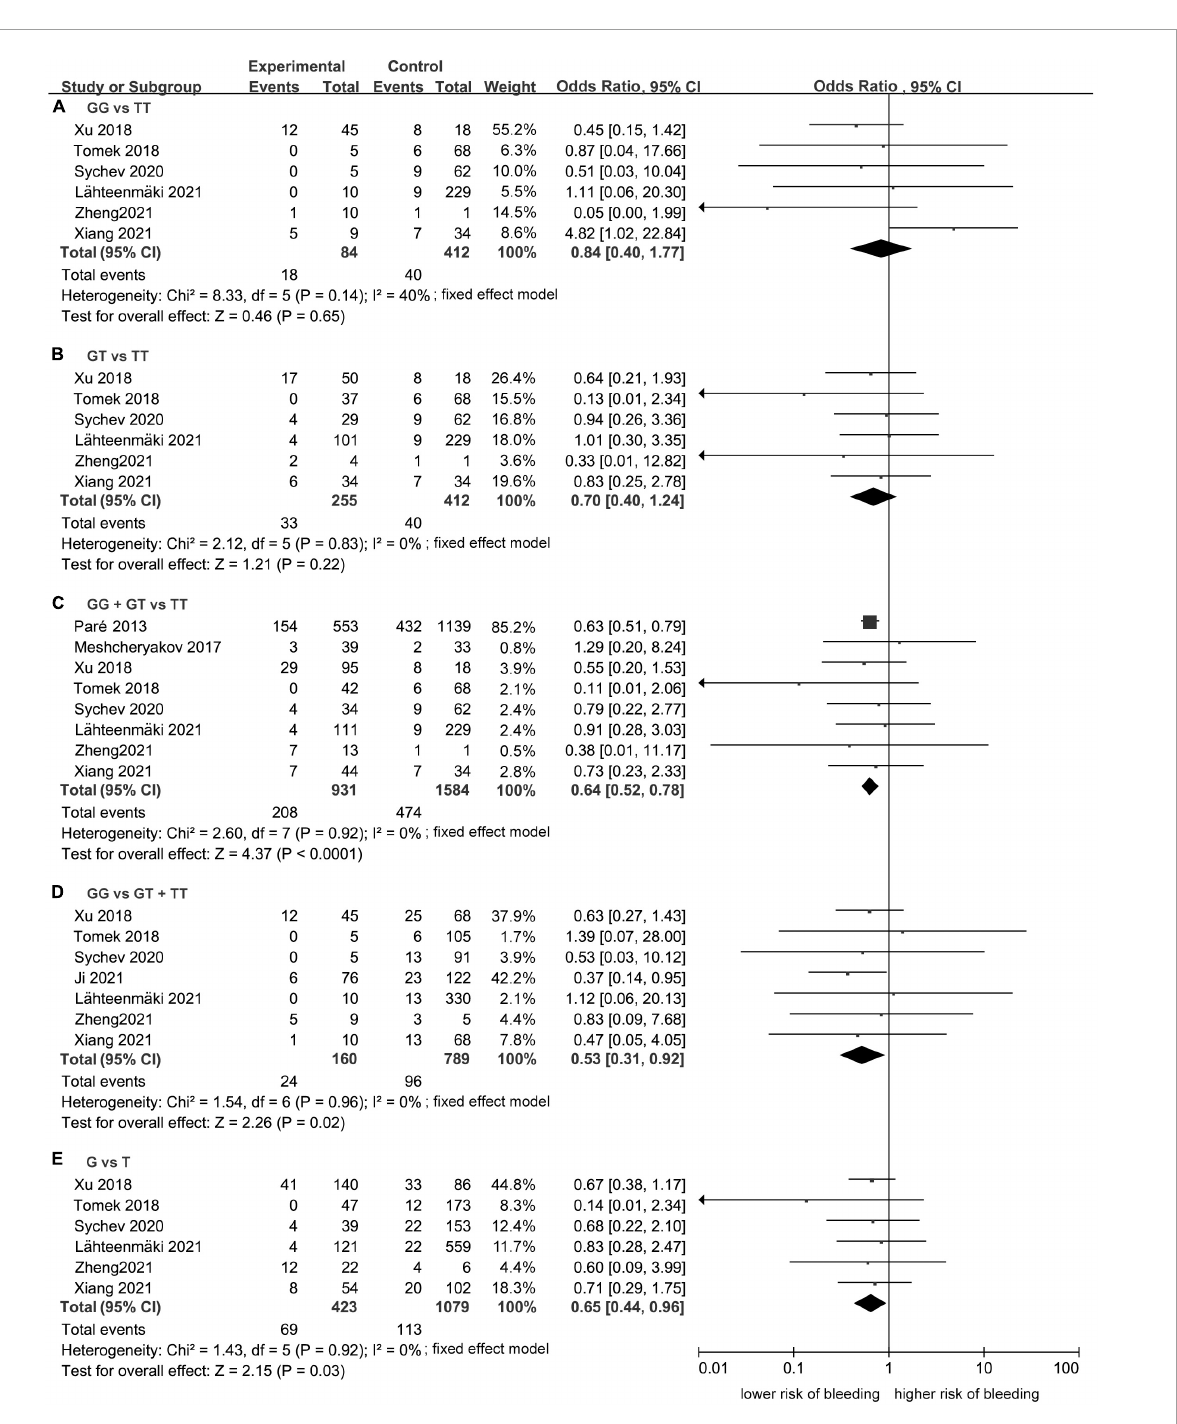
FIGURE5 Forest plots comparing the risk of developing any bleeding event across rs2244613 genotype polymorphism of the carboxylesterase 1 ( CES1 ) gene: (A) homozygote model, (B) heterozygote model, (C ) dominant model, (D) recessive model, and (E) allelic model.